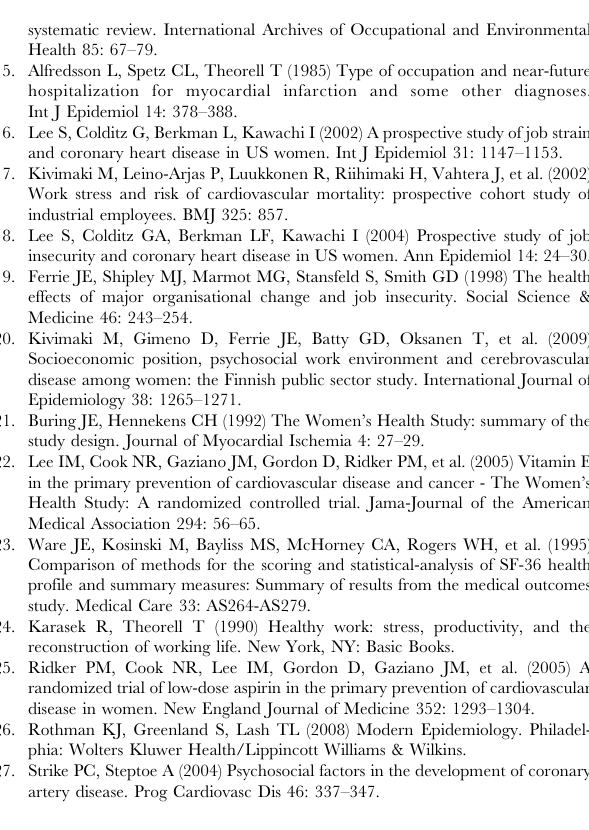
Figure S1 Flow Chart of Sample. Table S1 Comparison of baseline characteristics for participants in main analysis (N= 22,086) and partici- pants excluded from main analysis due to missing work stress questions (N= 10,833) or critical covariates for Models 1 and 2 (N =1748).